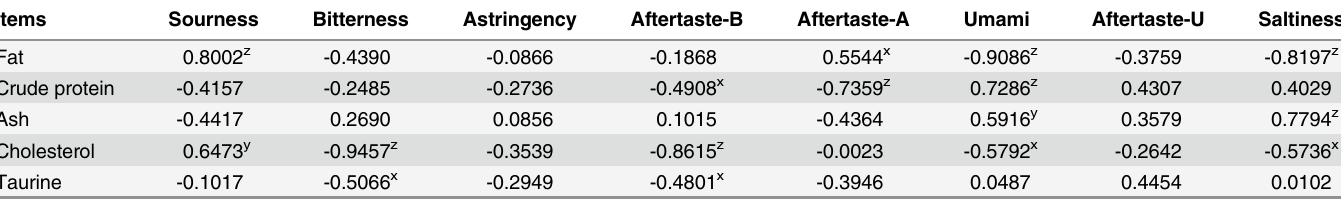
PCA score plot to discriminate different breeds of beef In order to better visualize the results, a principal component analysis (PCA) was carried out and the results are presented in Fig 3. The PCA map additionally exhibited the differences among different breeds according to the flavor of sourness, umami, saltiness, bitterness, astrin- gency, Aftertaste-B, Aftertaste-A and Aftertaste-U. The main variance was explained by the first component, the x-axis (PC-1), and the smaller part of the variance covered by the second principal component was shown on the y-axis (PC-2). PC-1 represented about 66% of the total information, 26% of the information was displayed by PC-2. The eigenvalues of PC-1 and PC- 2 were 5.29 and 2.11 respectively. Therefore, 92% differentiation between the samples was car- ried out with respect to PC-1, with additional information gained by PC-2. In addition, eigen- values of the flavor traits within the principal components are listed in Table 4. Sourness, bitterness, astringency, Aftertaste-B, Aftertaste-A and saltiness would increase with increasing PC-1, whereas umami and Aftertaste-U would decrease. The highest correlation flavor trait to PC-1 was astringency. Similarity, PC-2 also had six positive flavor traits, including umami, Table 2. The Pearson correlation coefficients between flavor and chemical composition. Items